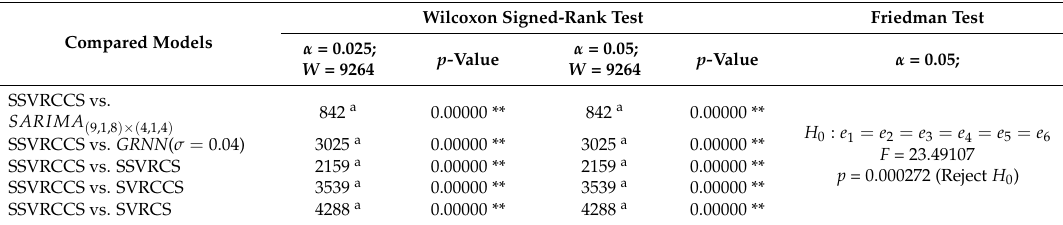
Table 4. Results of Wilcoxon signed-rank test and Friedman test for Example 1.